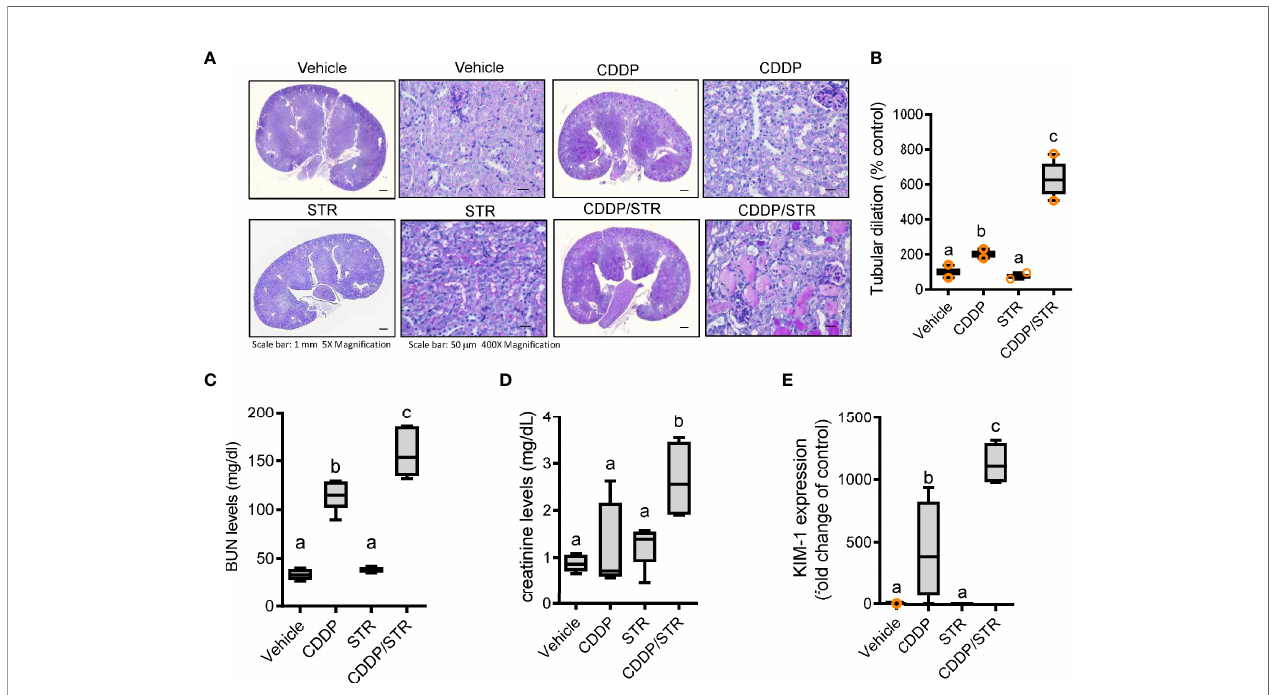
FIGURE 2 | Effects of STR exposure on CDDP-induced renal injury. Eight-week-old wild type male mice (n = 3 – 5) were orally pre-exposed to the vehicle or streptomycin (20 mg/mouse) for 24 h and then renal injury was induced with CDDP (20 mg/kg) via intraperitoneal administration for an additional 72 h. (A) Periodic acid-Schiff (PAS) staining. (B) Tubular dilation levels according to PAS staining. (C, D) levels of blood urea nitrogen (BUN, C ) and creatinine (D) . (E) The mRNA expression was measured in the mouse kidney using real-time RT-PCR. Results are representative of three independent experiments. The results are shown as a box plot with Tukey whiskers and the different letters (a – c) over each box represent signi fi cant differences between groups using ANOVA with Newman – Keuls method as a post hoc ANOVA assessment